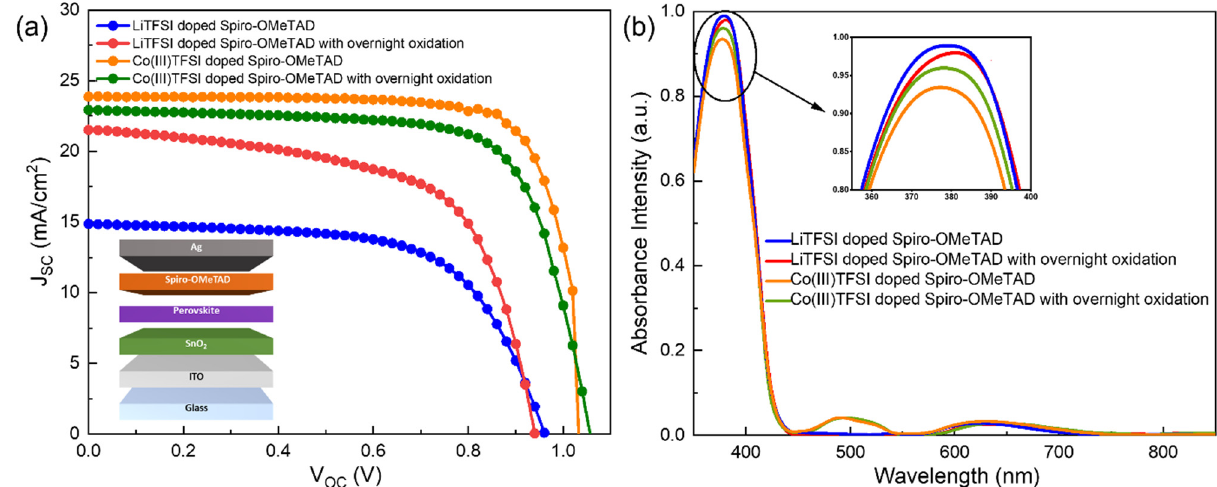
Figure 1. ( a ) J–V Characteristics of the perovskite solar cells with LiTFSI-doped spiro-OMeTAD and Co(III)TFSI co-doped spiro-OMeTAD under different oxidation conditions. The device structure of the fabricated n-i-p configuration perovskite solar cell is also shown in the figure, and ( b ) UV-Vis absorption spectra of doped spiro-OMeTAD films under different oxidation conditions. The figure in the inset shows the magnified portion of the UV-Vis spectra between 350 and 400 nm to clearly indicate the variation in the peak intensities. Table 1. Summary of the photovoltaic parameters of the perovskite solar cells employing LiTFSI-doped spiro-OMeTAD and Co(III)TFSI co-doped spiro-OMeTAD with and without overnight oxidation. V OC Device (V) PSC with LiTFSI-doped